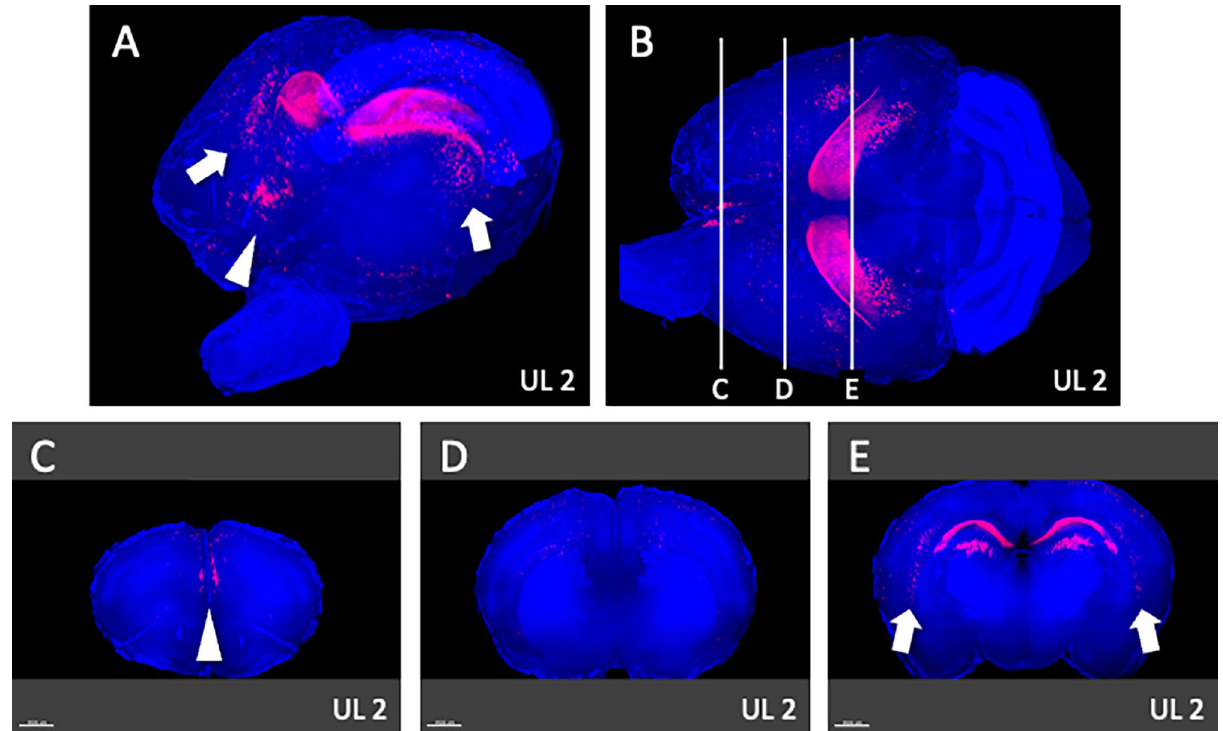
Figure 9. Survey on arbitrary cross sections on UL2. ( A ) Panoramic view of whole-brain imaging on day 2 after UL. Neural activity can be observed in the medial-frontal part (arrowhead) and the parietal-temporal part (arrows). ( B ) Images from the top of the brain. The vertical lines indicate the cross-sectional positions shown in panels ( C – E ). ( C ) Activated neurons in the medial frontal region (arrowhead, panel A ) were located in the medial prefrontal cortex (mPFC). ( D ) A cross section of the primary somatosensory cortex (S1) region shows the absence of any activated neurons in this area. ( E ) Activated neurons in the parietal-temporal region (arrows, panel A ) were located in the caudate putamen